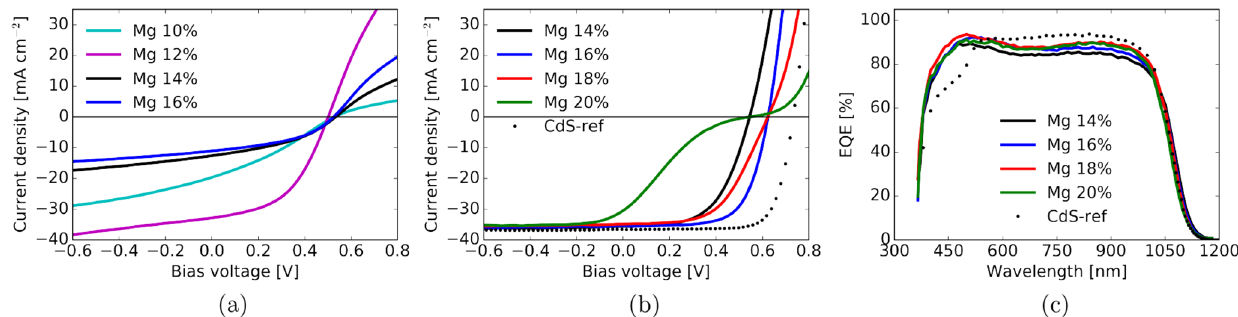
Fig. 2. (a) IV curves of samples treated with KCN only before buffer deposition. (b) IV curves of samples subjected to KCN and NH 4 OH treatment. (c) EQE of samples with absorbers treated with KCN and NH 4 OH.